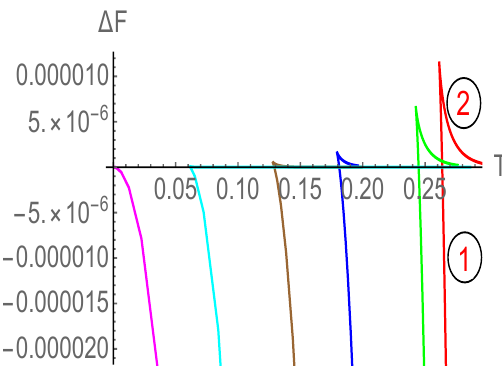
Figure 2 . 4 F = F Black hole (cid:0) F Thermal-AdS as a function of T for various values of (cid:22) . Here red, green, blue, brown, cyan and magenta curves correspond to (cid:22) = 0, 0 : 2, 0 : 4, 0 : 5, 0 : 6 and 0 : 673 respectively. In units